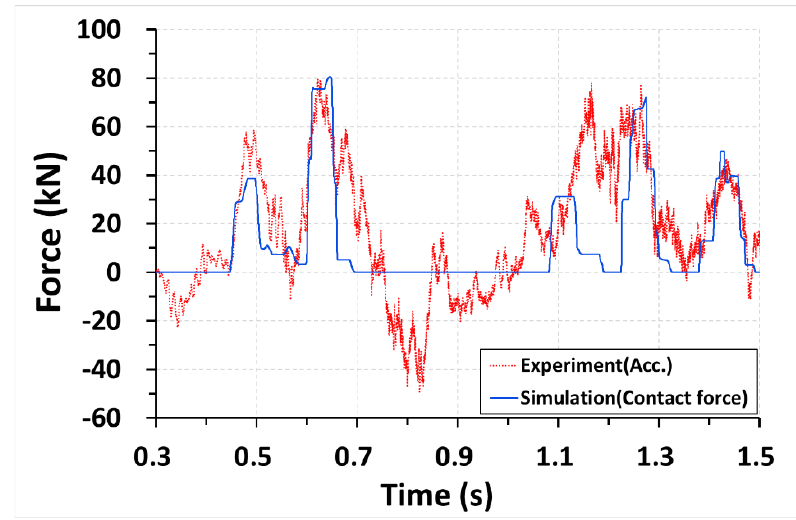
Figure 14. Collision load of the wheels of the flat wagon.